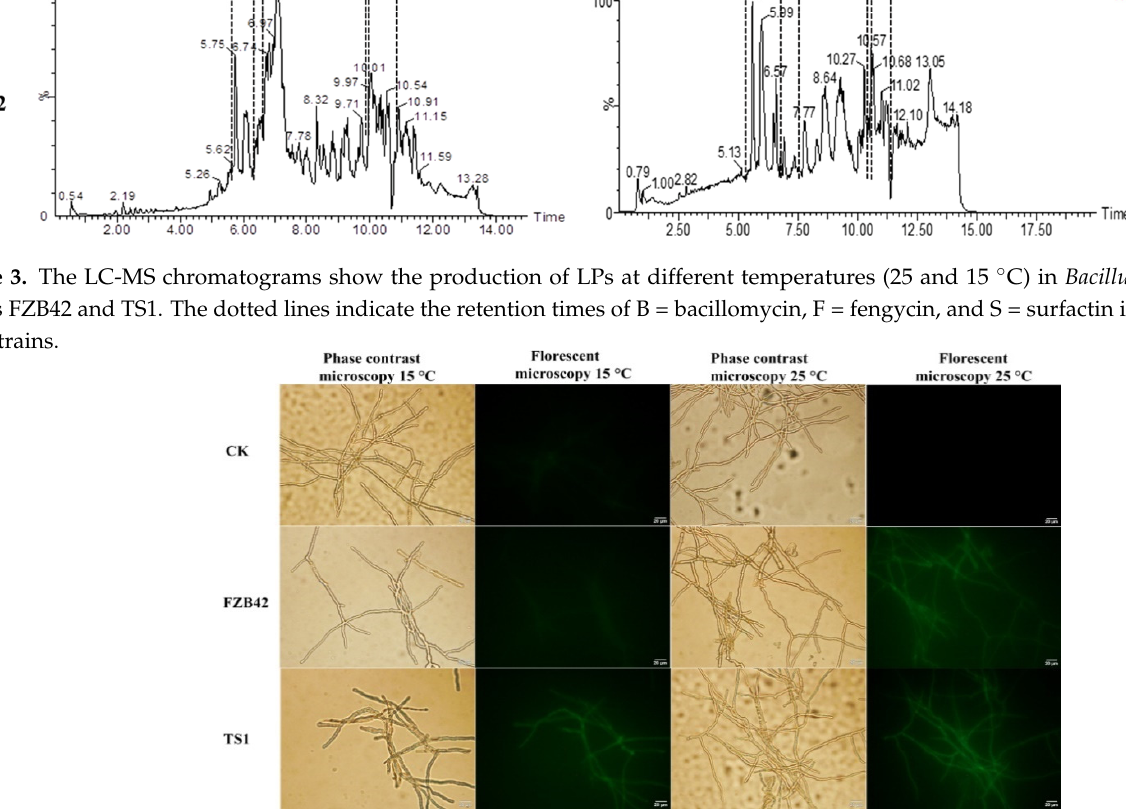
Figure 4. The ROS production in fungal F. graminearum hyphae after being treated with Bacillus strains FZB42 and TS1 at cold condition 15 °C and normal condition 25 °C. The sterilized LB medium was used to treat the hyphae as a control. The experiment was repeated independently three